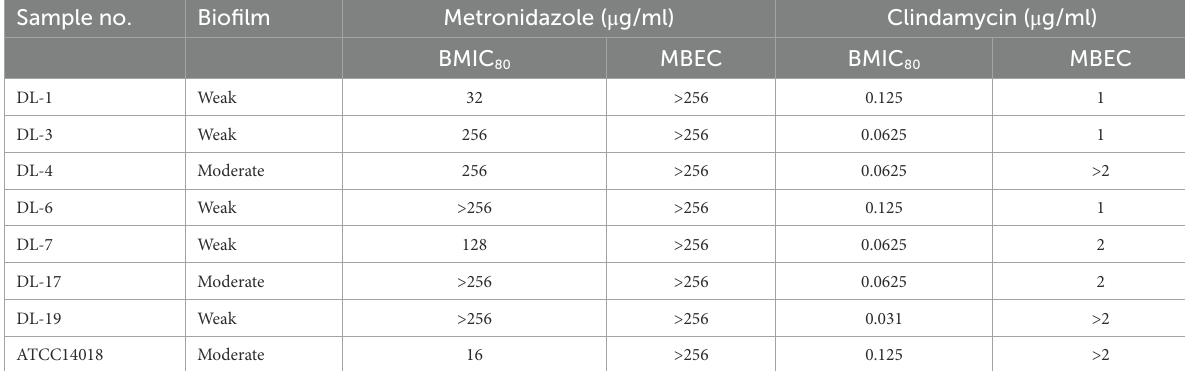
TABLE 2 Antimicrobial susceptibility of G. vaginalis clinical samples grown as biofilms. Sample no.